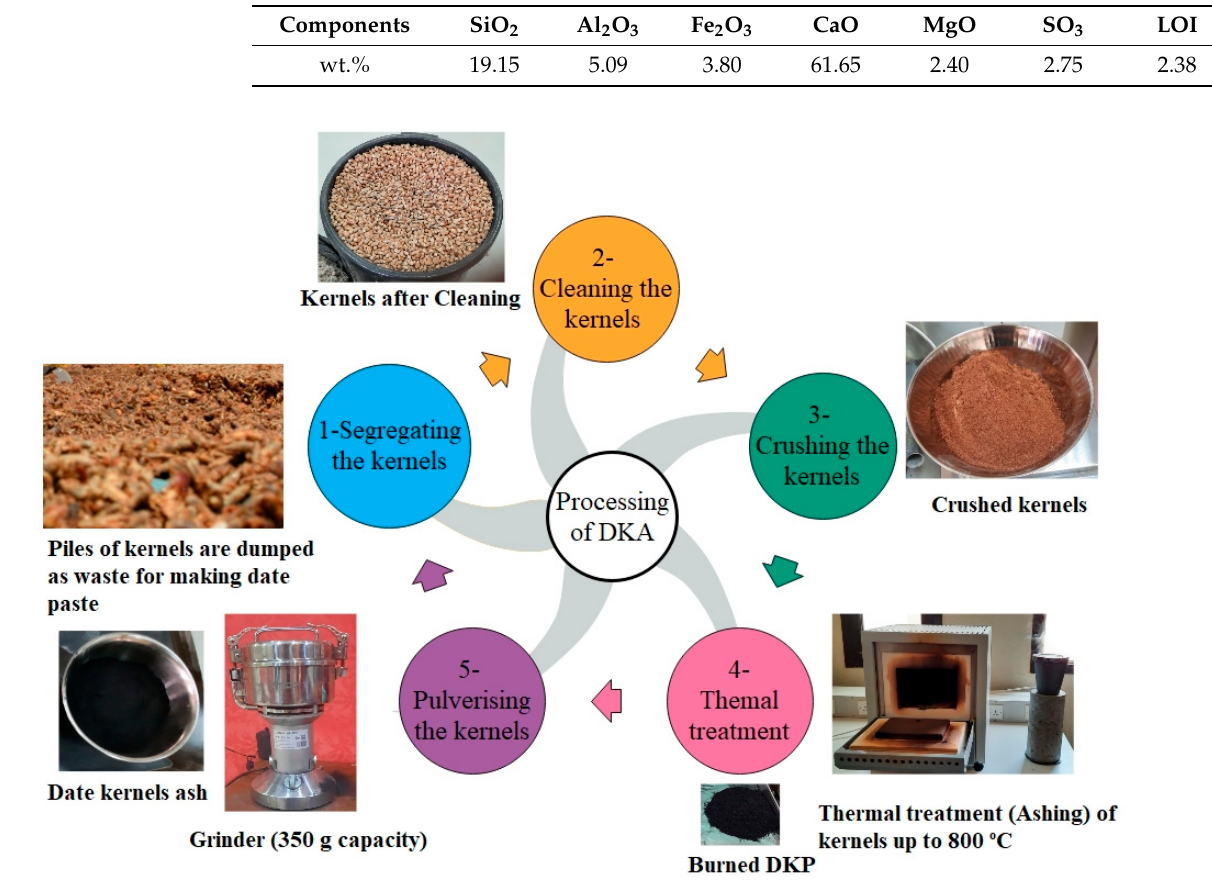
Figure 3. Process of making date kernel ash (DKA).